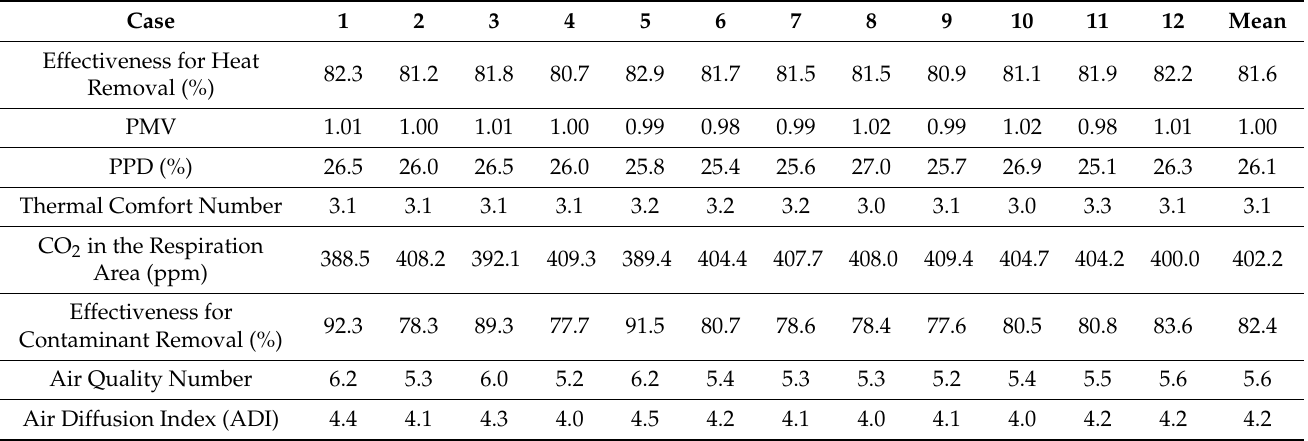
Table 7. ADI obtained for Case II (0.1167 m 3 /s) at 10 h.